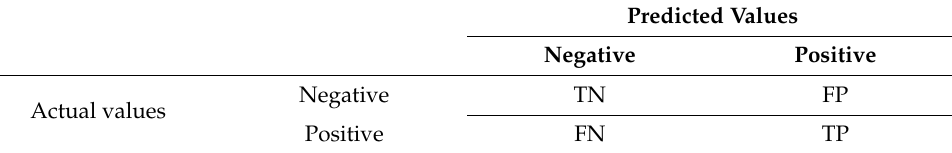
Table 4. The confusion